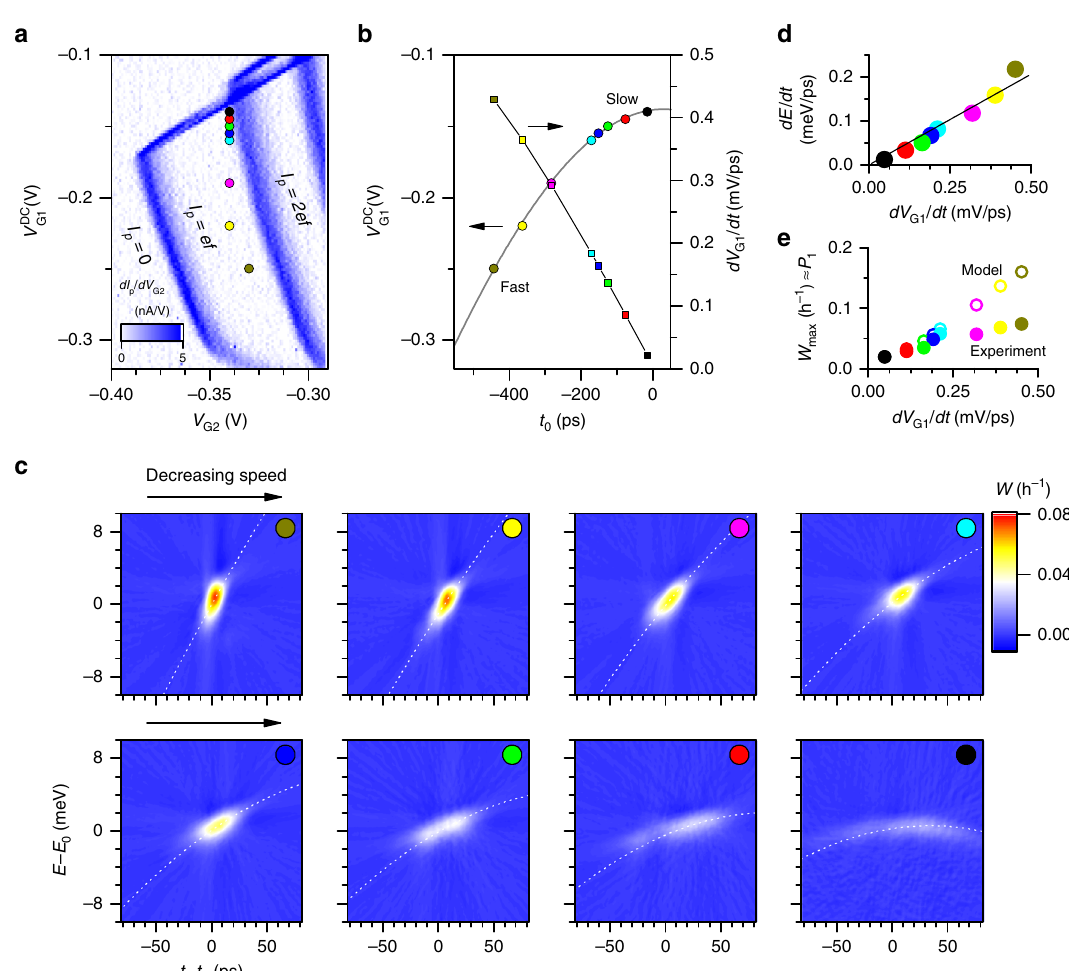
Fig. 3 Tomography of excitations produced under different ejection conditions. a Coloured points show different operating points within the one electron/ cycle pump current plateau whose boundaries are visible in this plot of dI p = dV . b Circular symbols indicate measured time of arrival, t 0 at each of the V G2 G1 operating points in a . Square symbols show the estimated barrier sweep rate at these times. c Single electron tomography for each pump operating points in a , as indicated by the coloured dots (top left is the fastest sweep rate, bottom right is the slowest). Dashed lines are the ejection trajectories calculated with a semiclassical model (See Supplementary Note 4 and Supplementary Figs. 5 – 7). d single electron chirp rate dE = dt as measured from fi ts to the backprojection at each sweep rate on the pumping gate (the solid line is a linear fi t). e Solid symbols are the measured peak phase space density (cid:7) P . 1 Open symbols are from a model that accounts for energy